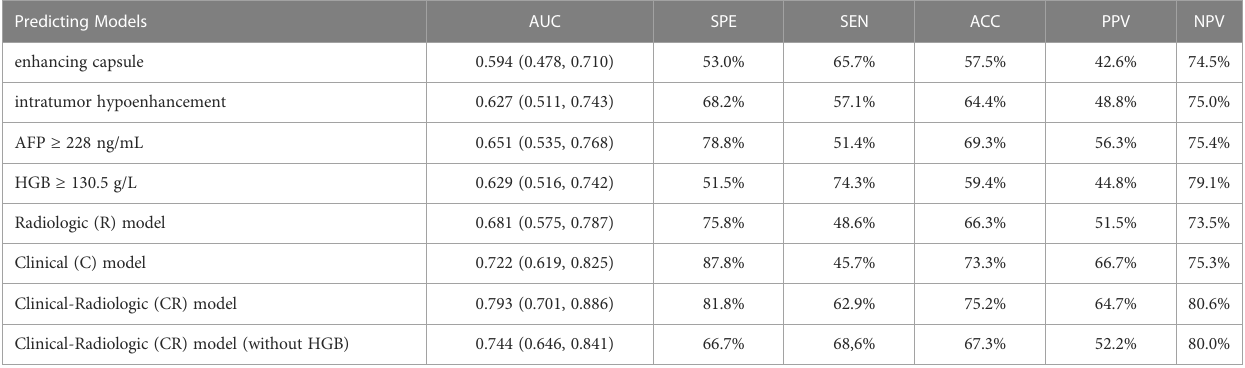
TABLE 5 Diagnosis performance of MTM-HCC predictive models.